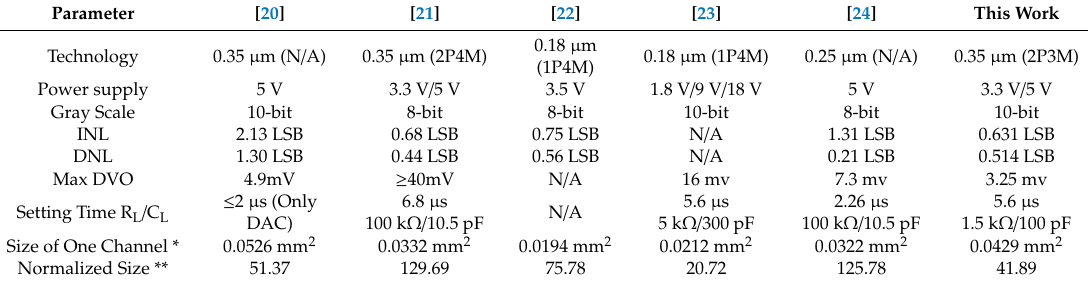
Table 1. Performance summary and